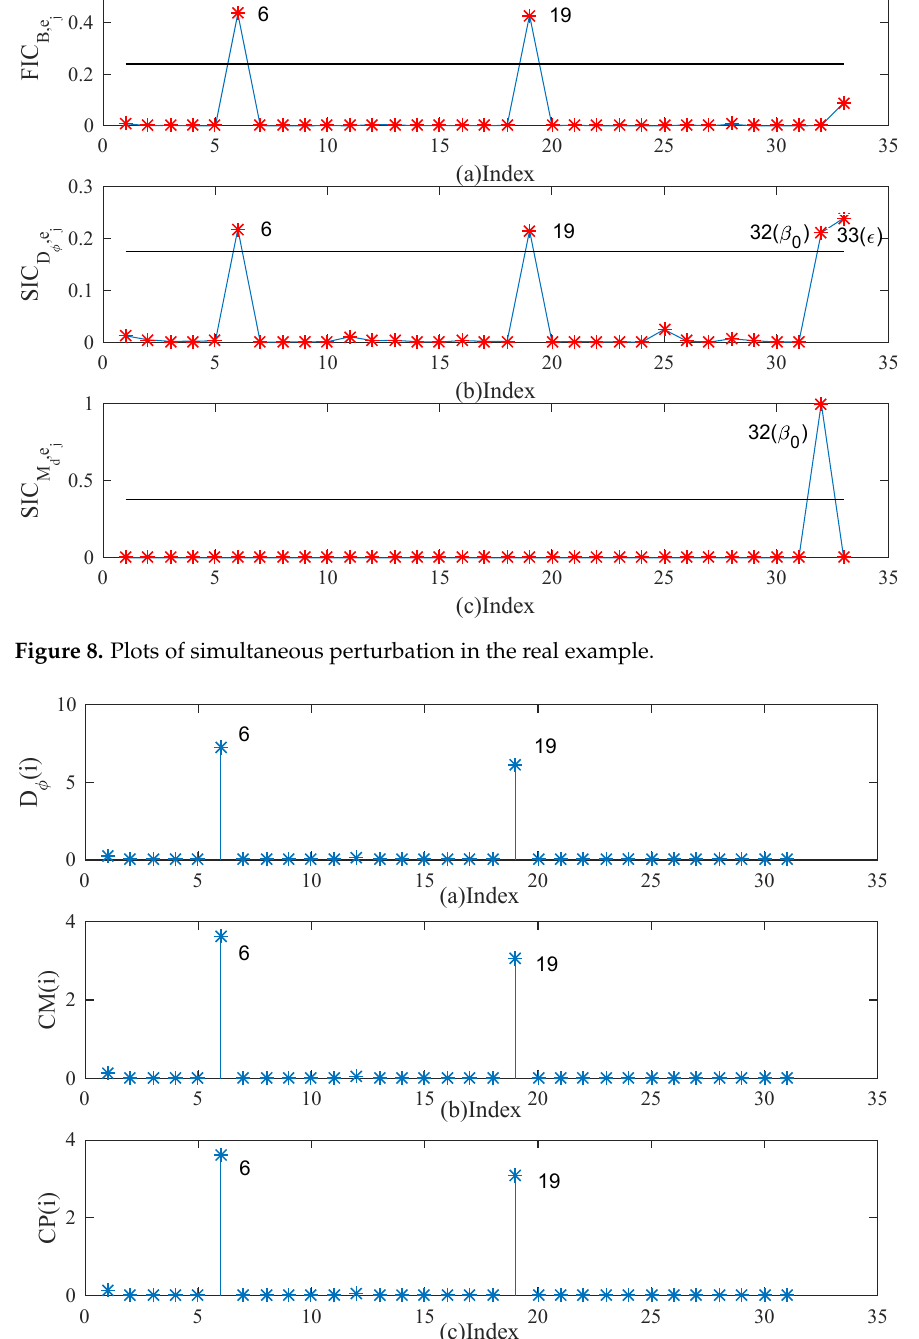
Figure 9. Diagnostic plots of covariate outliers in the real example.